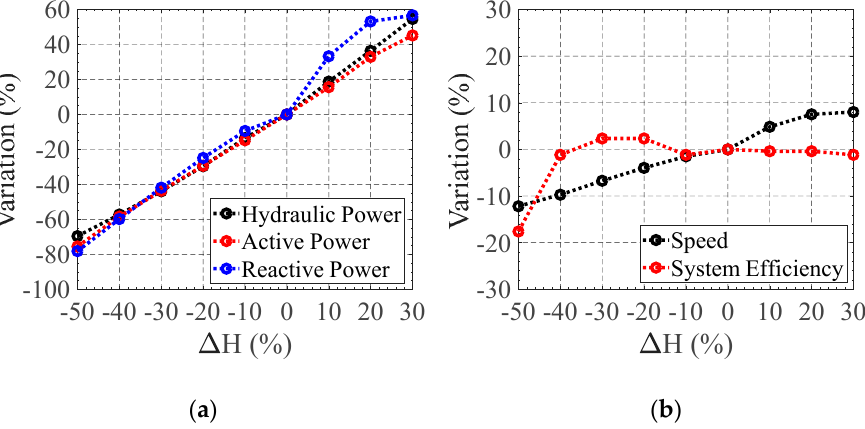
Figure 20. Variation of hydraulic and electromechanical parameters after a change in the PAT head, ∆ H : ( a ) variation of hydraulic (black), active (red) and reactive (blue) powers, and ( b ) variation of speed (black) and system (red) efficiency.